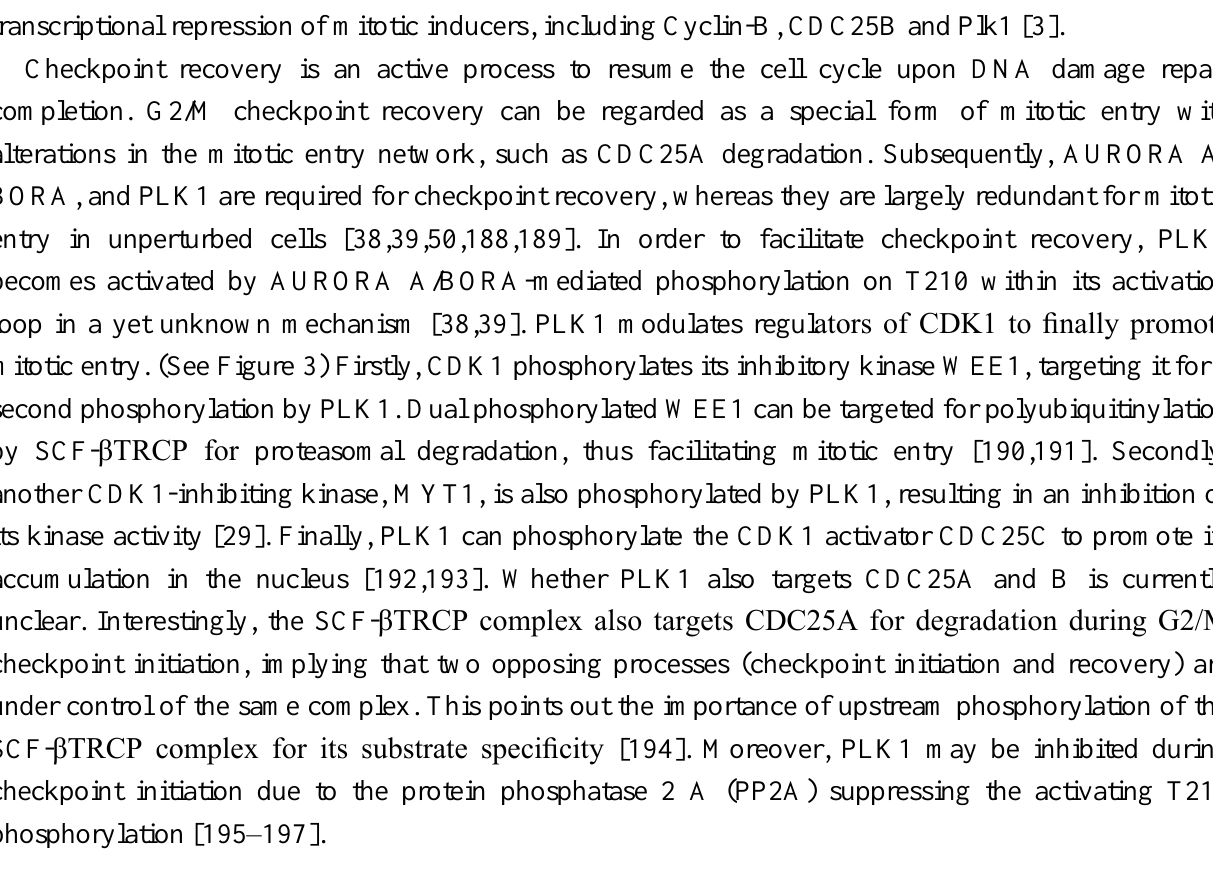
Figure 3. Plk1-dependent recovery from DNA damage induced cell cycle arrest. (A)